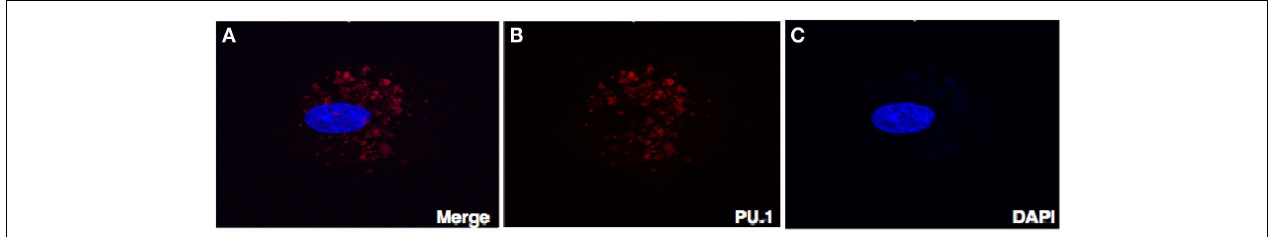
antibody and then probed with goat-anti-rabbit Cy3 (B) , counterstained with DAPI (C) , and analyzed by confocal microscope (A) . Original magnification 60 × .